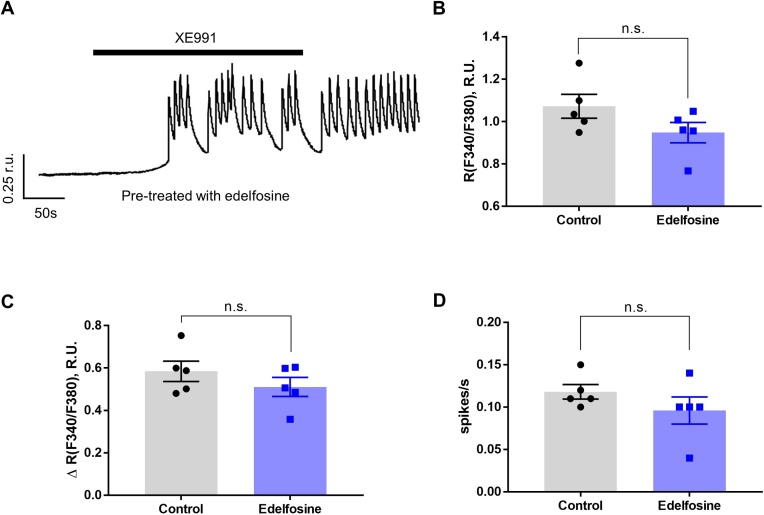
Ca2+ oscillations induced by Kv7 channel inhibition are insensitive to PLC inhibition. (A) Representative example trace showing Ca2+ oscillations (indicated as F340/F380 ratio units; r.u.) evoked by XE991 (10 μM) in A7r5 cells pretreated with PLC inhibitor, edelfosine (10 μM). (B-D) Bar graphs summarising the effects of edelfosine on the peak Ca2+ level (B), Ca2+ response amplitude (ΔR; C) and Ca2+ spike frequency (spikes/s) (D) induced by XE991. In panels B-D data are presented as mean ± S.E.M.; n.s., not significant; (n = 5).